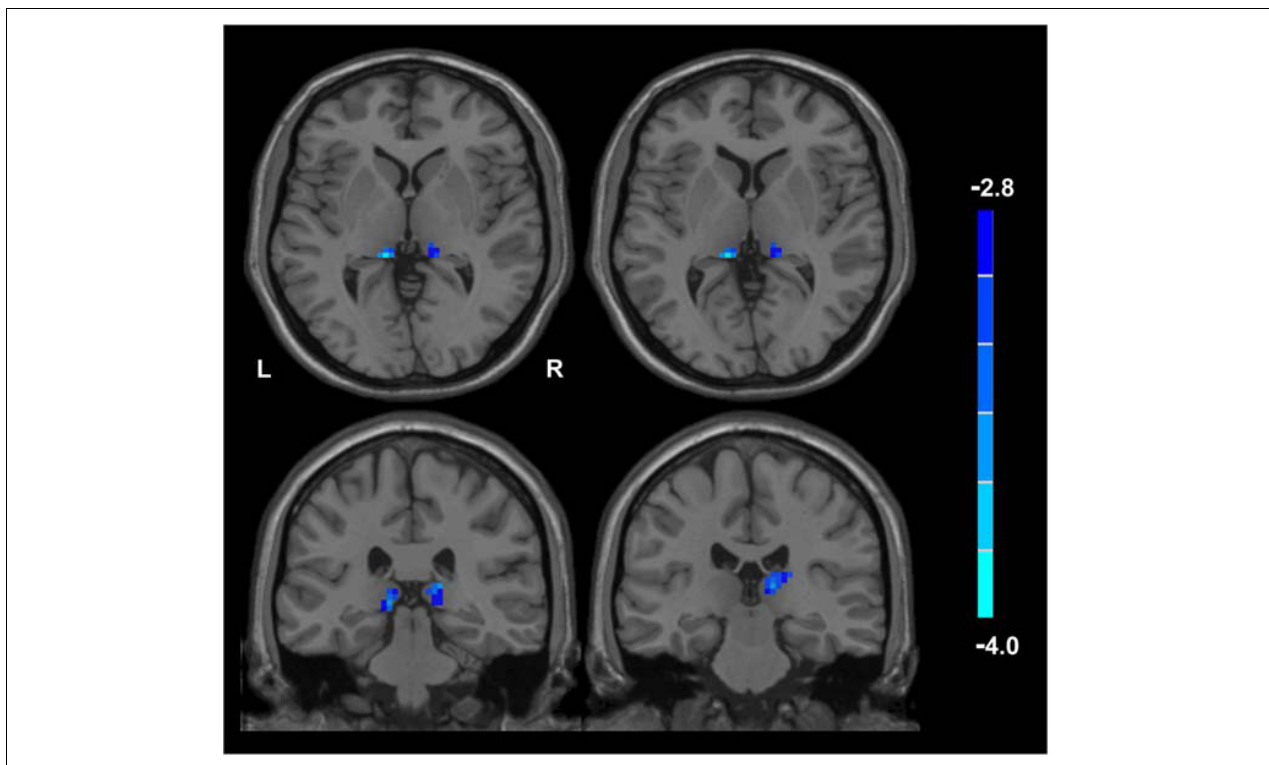
FIGURE 1 | Functional connectivity (FC) between the wives and husbands in the non-PTSD group. Compared with the non-PTSD husbands, the non-PTSD wives had weaker FC between the right hippocampal CA3 and the bilateral thalamus ( p < 0.05, corrected). PTSD, post-traumatic stress disorder; CA, Cornu Ammonis.